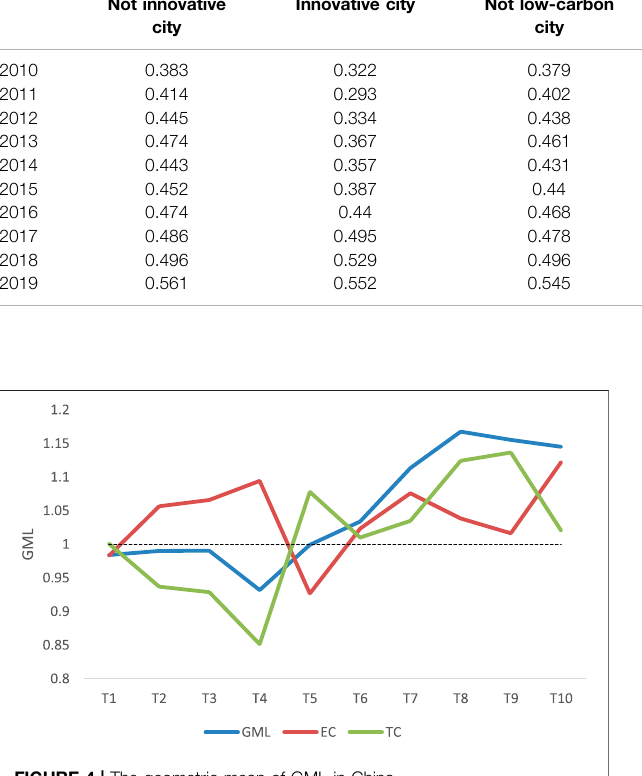
FIGURE 4 | The geometric mean of GML in